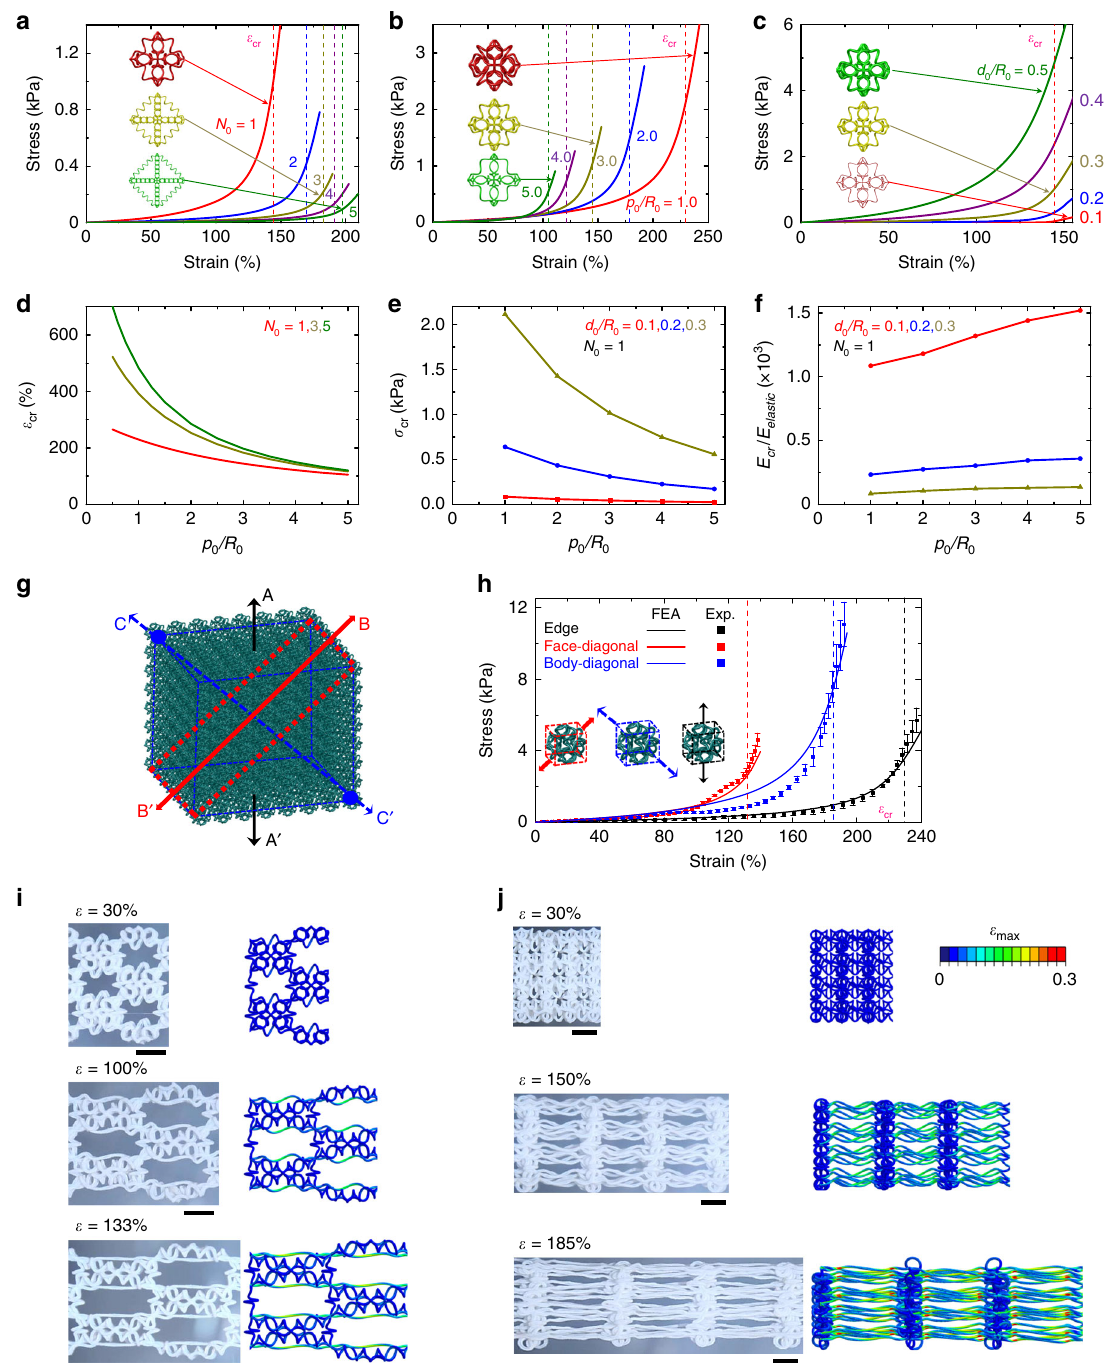
Fig. 3 Design rules and mechanical responses along different characteristic directions. a – c Effects of three key dimensionless geometric parameters (the number N 0 of the coil, the normalized pitch p 0 / R 0 , and the normalized fi ber diameter d 0 / R 0 ) on the J-shaped stress – strain curves of soft octahedral network materials. d Critical strain of the J-shaped stress – strain curve vs. the normalized pitch p 0 / R 0 for different numbers N 0 of the coil. e , f Effective critical stress and modulus ratio E cr / E elastic vs. the normalized pitch p 0 / R 0 for different normalized fi ber diameters d 0 / R 0 . g Schematic diagram of soft octahedral network materials under uniaxial tension along the edge, face-diagonal, and body-diagonal directions, denoted by A – A ′ , B – B ′ , and C – C ′ , respectively. h Experimental and FEA results of J-shaped stress – strain curves for soft octahedral network materials under uniaxial tension along the edge, face-diagonal, and body-diagonal directions. i Experimental and FEA images of the middle segment in a soft octahedral network structure under different levels of uniaxial stretching along the face-diagonal direction. j Similar results under uniaxial tension along the body-diagonal direction. Scale bars, 5 mm